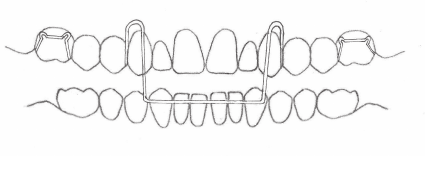
Figure 2: Eschler